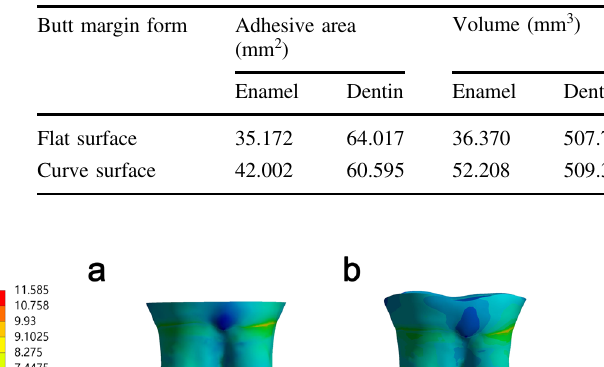
Table 3 Volume and adhesive area of the remained enamel and dentin in two types of butt margin models in the preparation of